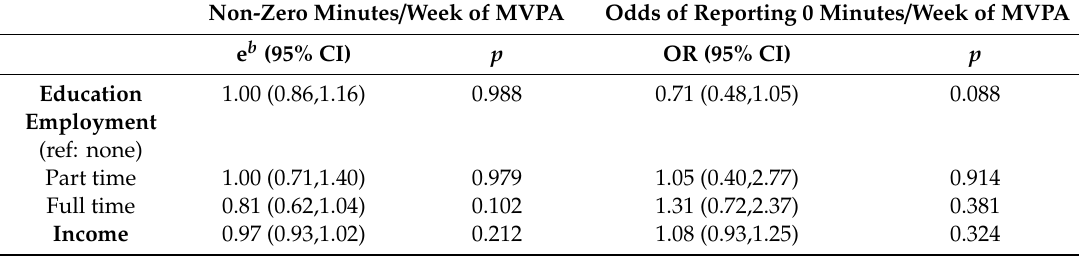
Table 3. Associations of mothers’ socio-economic status indicators with moderate to vigorous physical activity (total e ff ects a